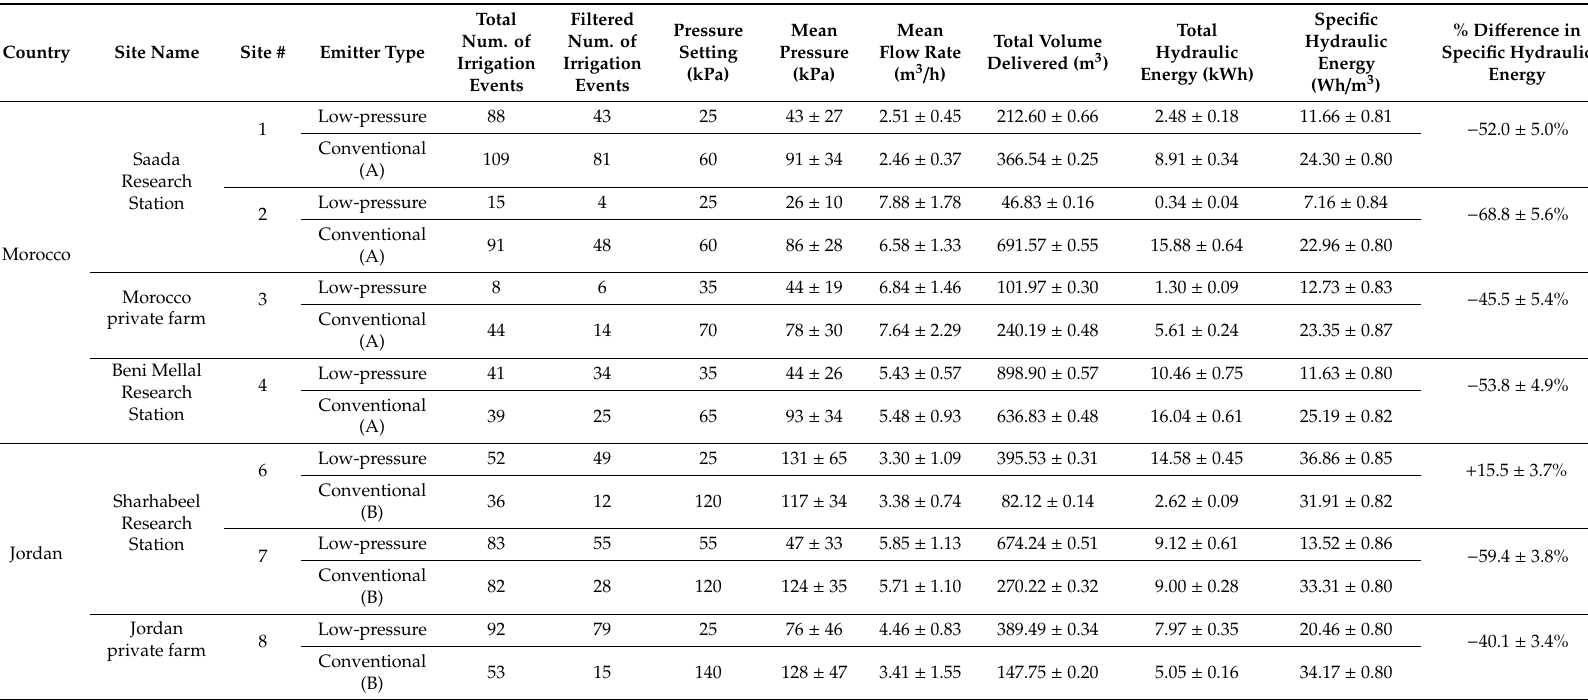
Table 3. Summary of pressure and flow measurements and hydraulic energy calculations for experimental plots with sensor measurements. The filtered number of irrigation events refers to the number of events with pressures that passed the filtering criteria (average pressure during event ≥ 80% × p set ) and do not include every irrigation event from the season. The values of pressures, flow, and energy are based on the irrigation events that passed the filtering criteria only. Mean pressures and flow rates are listed with the standard deviations over all included irrigation events. Total volume, total hydraulic energy and specific hydraulic energy are listed with the measurement uncertainty. The last column is calculated as the di ff erence between the specific hydraulic energy of low-pressure emitters and that of conventional emitters, divided by the specific hydraulic energy of conventional emitters and expressed as a